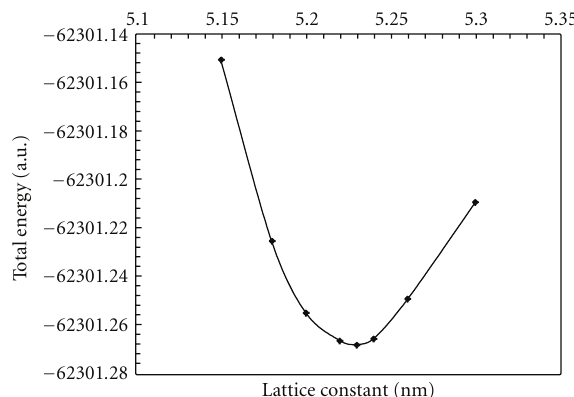
Figure 1: Total energy of 216 atoms aluminum phosphide core LUC as a function of lattice